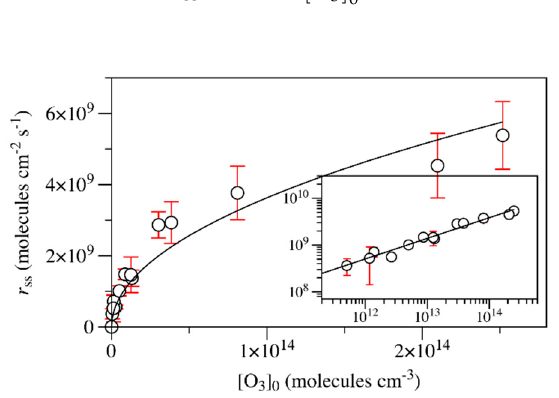
Figure 3. Evolution of r ss as a function of ozone initial concentration [O 3 ] 0 . The solid line displays the power function fitting of r ss and [O 3 ] 0 . The embedded figure corresponds to the logarithmic display mode. Experiments were carried out at room temperature and atmospheric pressure using a fixed bed reactor. Error bars were determined from the overall experimental dispersion.